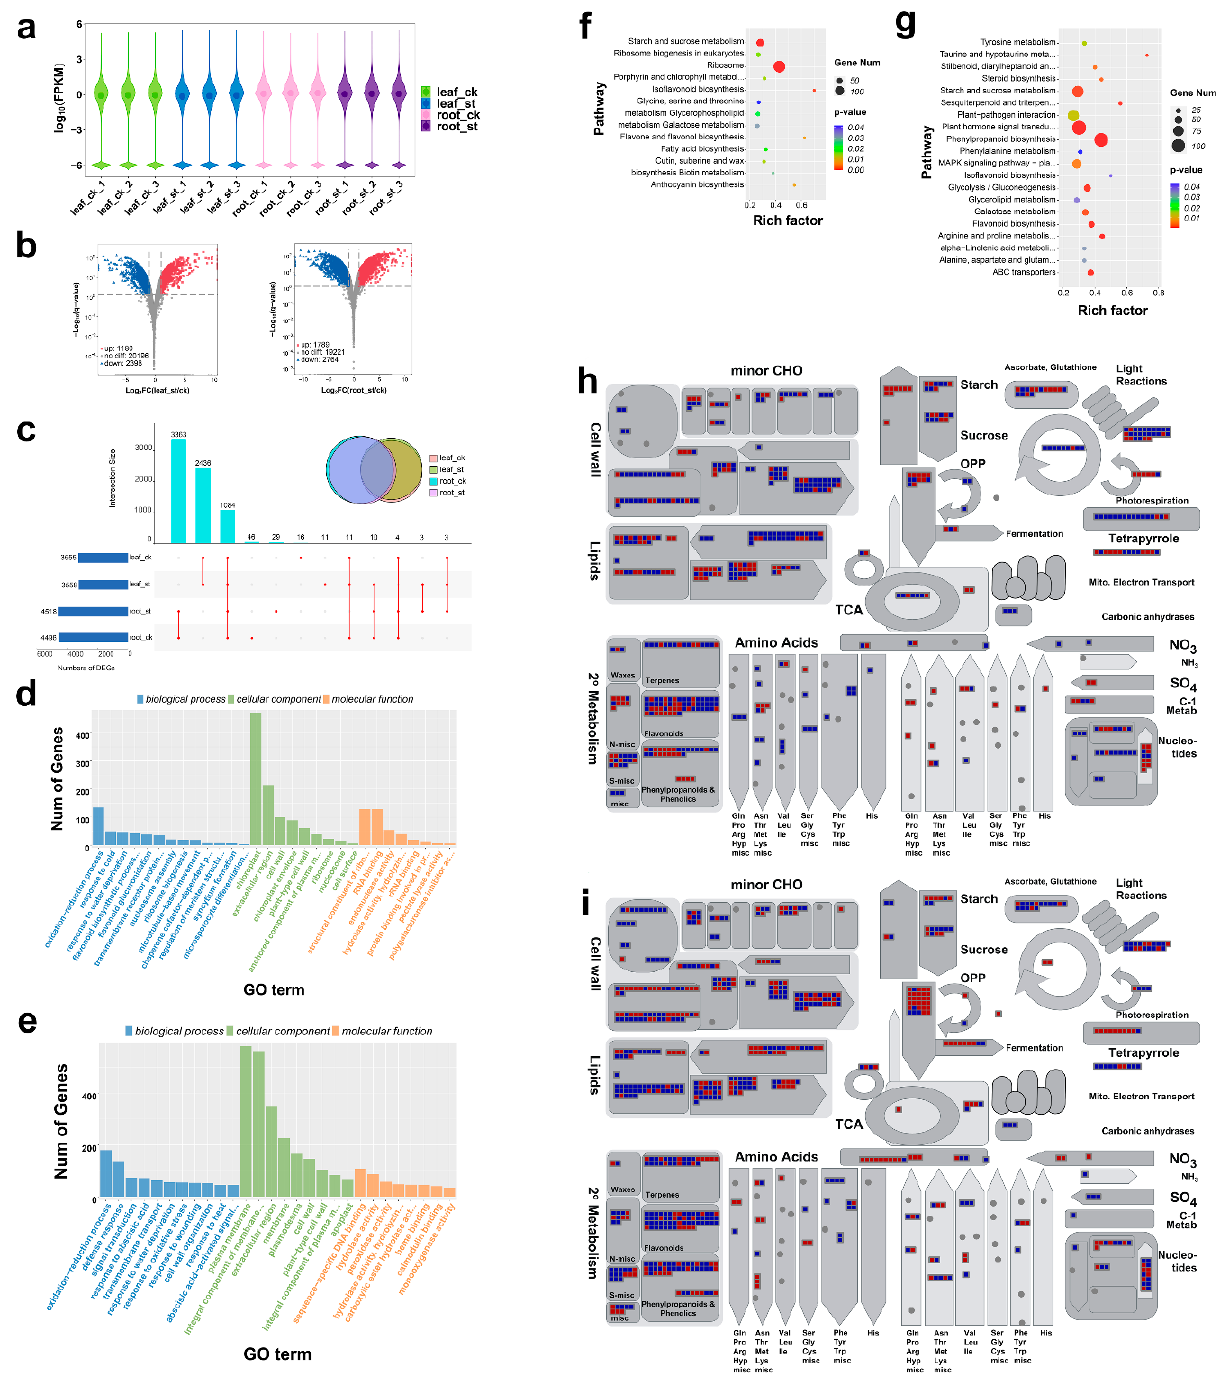
Figure 1. Identification and analysis of differentially expressed mRNAs (DEmRNAs) under salt stress. ( a ) Violin Plot of gene expression patterns for each sample, with origin representing the median; ck represents the control group and ST represents the treatment group. ( b ) Volcano Plot of log2 FC(ST/CK) of leaves and roots mRNAs. ( c ) Visualization of DEmRNAs in each sample, where the intersection size represents those common to all samples, intersection size stands for the common DEmRNAs among different samples. ( d – e ) gene ontology (GO) annotation in leaves ( d ) and roots ( e ). ( f , g ) Kyoto Encyclopedia of Genes and Genomes (KEGG) enrichment in leaves ( f ) and roots ( g ). ( h , i ) Mapman analysis of metabolism in leaves ( h ) and in roots ( i ), where each square represents mapping to the metabolic pathway and color represents up-regulation (red) or down-regulation (blue).